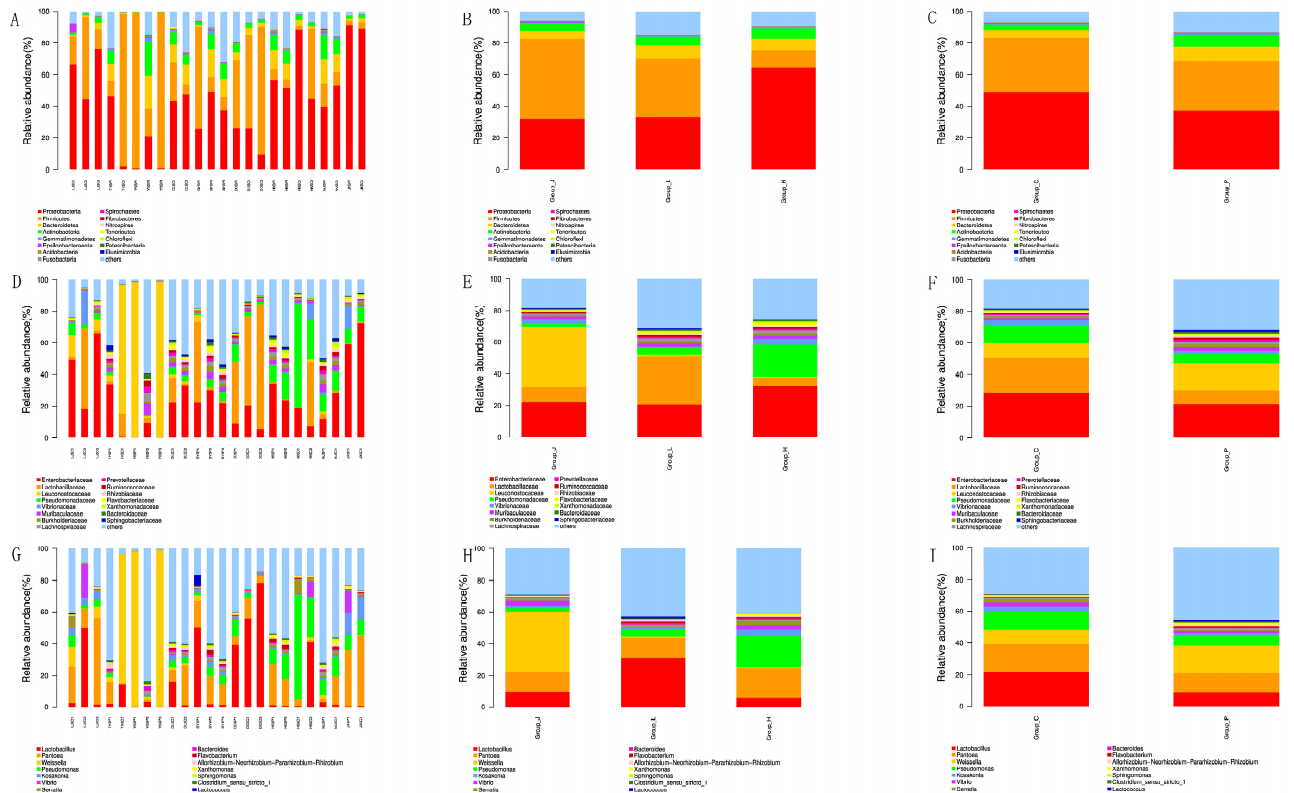
Figure 2. Relative abundance of bacterial communities at phylum ( A – C ), family ( D – F ), and genus ( G – I ) levels in samples of CSC. (Group_P: retail-produced, Group_C: home-made; Group_J: Jilin Province, Group_L: Liaoning Province, and Group_H: Heilongjiang Province).